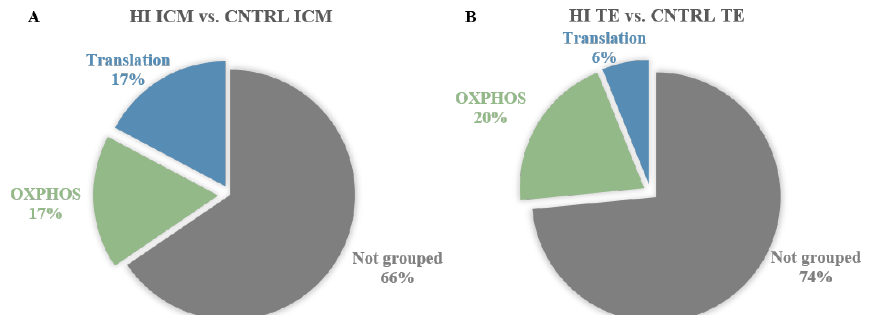
Figure 4. Significantly enriched gene sets (FDR < 0.05) in ICM and TE transcriptomes of in vitro- developed blastocysts with HI compared to CNTRL. Significantly enriched gene sets were identified by GSEA with the Molecular Signature Database (MSigDB) gene set collections: Hallmarks, KEGG, Reactome, and GO BP. GSEA was followed by SUMER analysis for gene set condensation. ( A ). Pie charts showing the enriched gene sets in HI ICM versus CNTRL ICM. ( B ). Pie charts showing the enriched gene sets in HI TE versus CNTRL TE. ICM, inner cell mass. TE, trophectoderm.